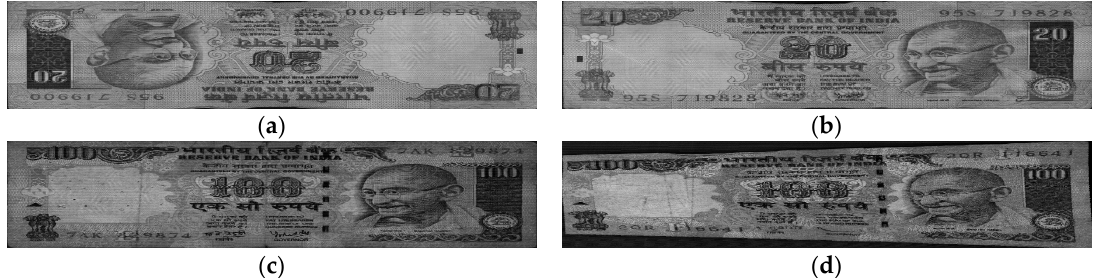
Figure 11. Examples of false recognition cases by our method in the INR dataset: ( a ) fit banknote misclassified to normal; ( b ) normal banknote misclassified to fit; ( c ) unfit banknote falsely recognized